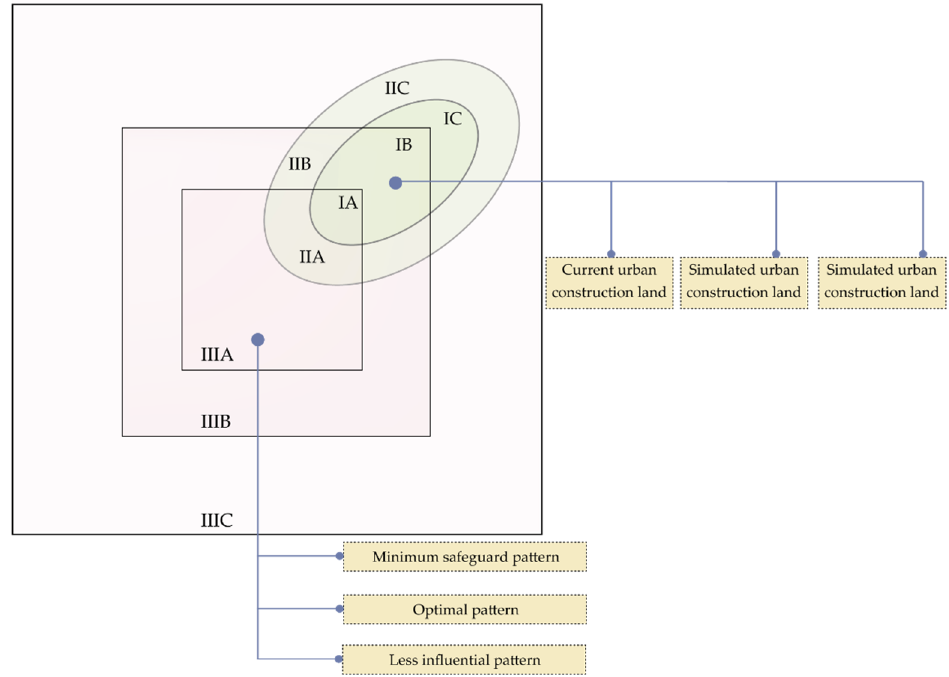
Figure 4. Analysis diagram of urban spatial regionalization method.